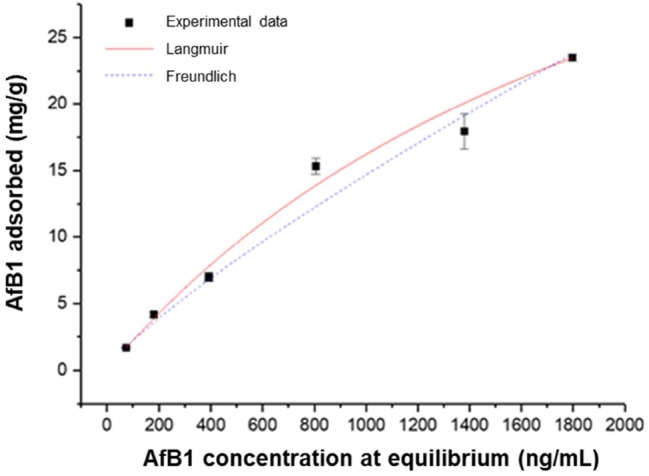
Effect of mycotoxin concentration on AfB1 adsorption by mycelium. Equilibrium adsorption isotherms were obtained at constant temperature (37°C) and pH (7) by testing a fixed amount of mycelium with increasing mycotoxin concentration.